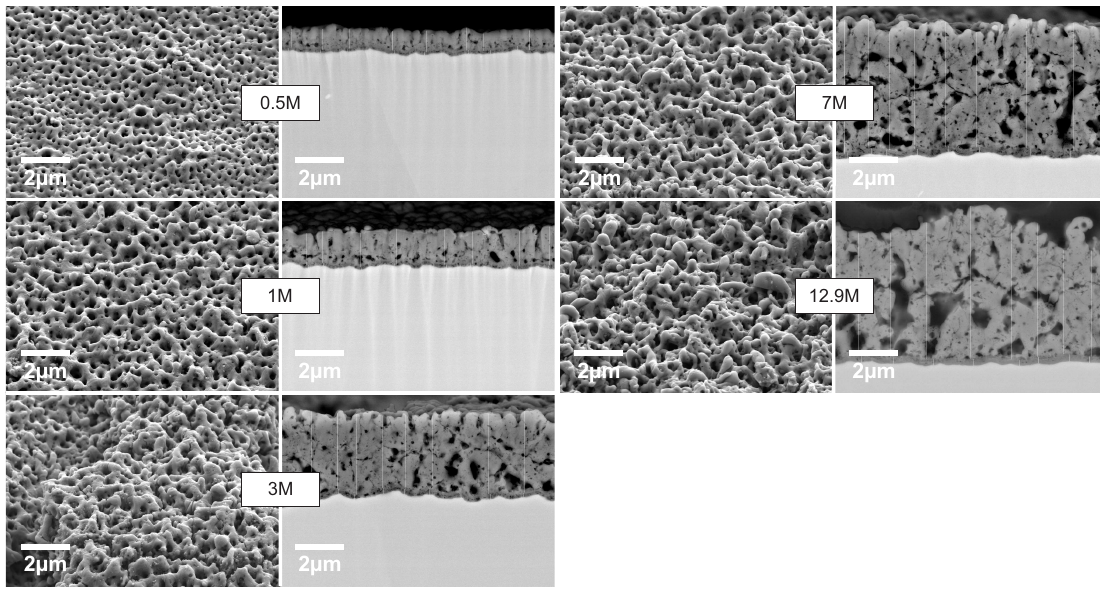
Figure 2. Scanning electron microscope surface and cross-section images from samples prepared with